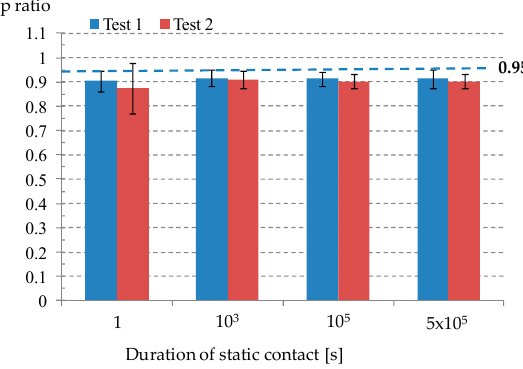
Figure 7. The average slip ratio. A slip ratio of 0.95 indicates the transition from a gross slip regime to a reciprocal sliding regime.